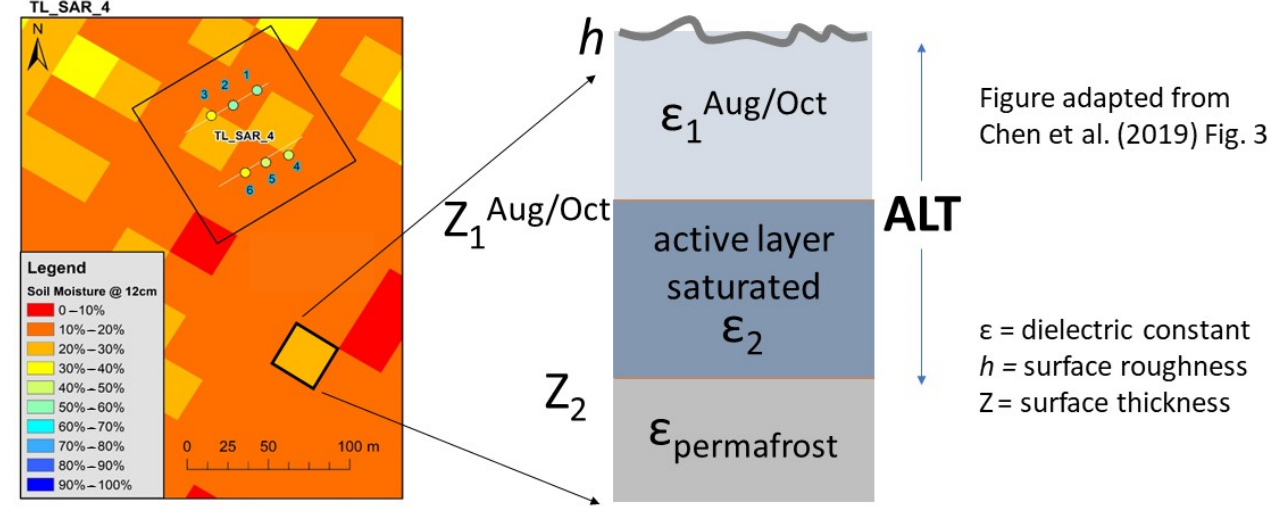
Figure 2. An example soil profile for a given pixel of the Chen et al. (2019) product. Each pixel has a surface roughness h , which is constant between the August and October SAR backscatter retrievals. The saturated active layer has a consistent dielectric ( ε 2 ) constant that depends only on the soil porosity. Between retrievals of the SAR instrument, the depth of the unsaturated surface layer (Z 1 ) and the dielectric constant of the unsaturated surface layer( ε 1 ) change. Z 2 is the depth of the active layer which is assumed to not vary substantially between maximum thaw (August) and partially frozen (October) in which most of the freezing occurs from the top down. The square labeled ‘TL_SAR_4’ is a ground-truthing plot established by the Next Generation Ecosystem Experiment Arctic (NGEE Arctic) with labeled points representing in situ soil moisture observations. Figure is adapted from Chen et al 2019, Figure 3.